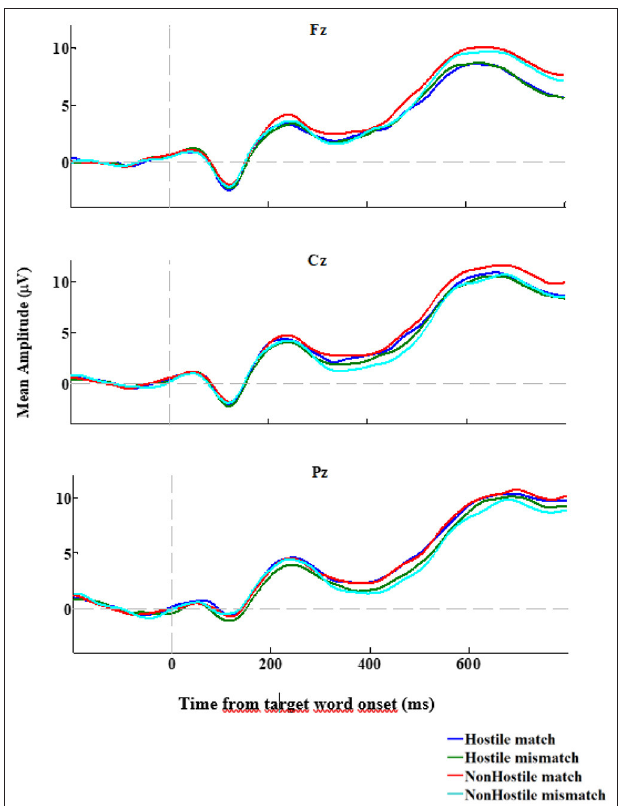
FIGURE 1 | ERP waveforms at electrodes of anterior, central and posterior sites of the midline for the match and mismatch, and hostile and non-hostile condition (blue: hostile-match; green: hostile-mismatch; red: non-hostile-mismatch; aqua: